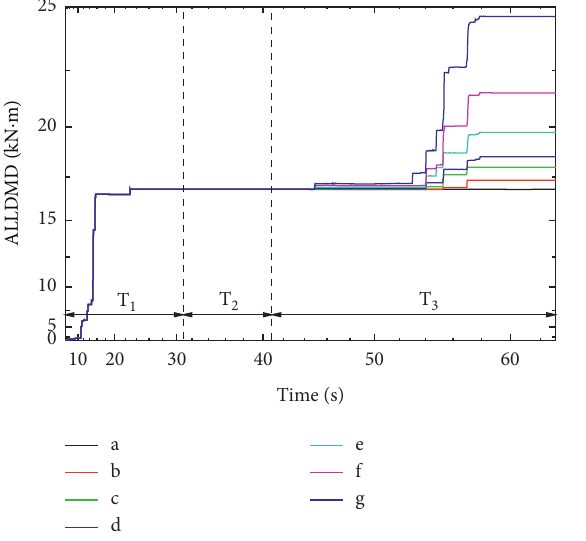
Figure 9: Damage dissipated energy.